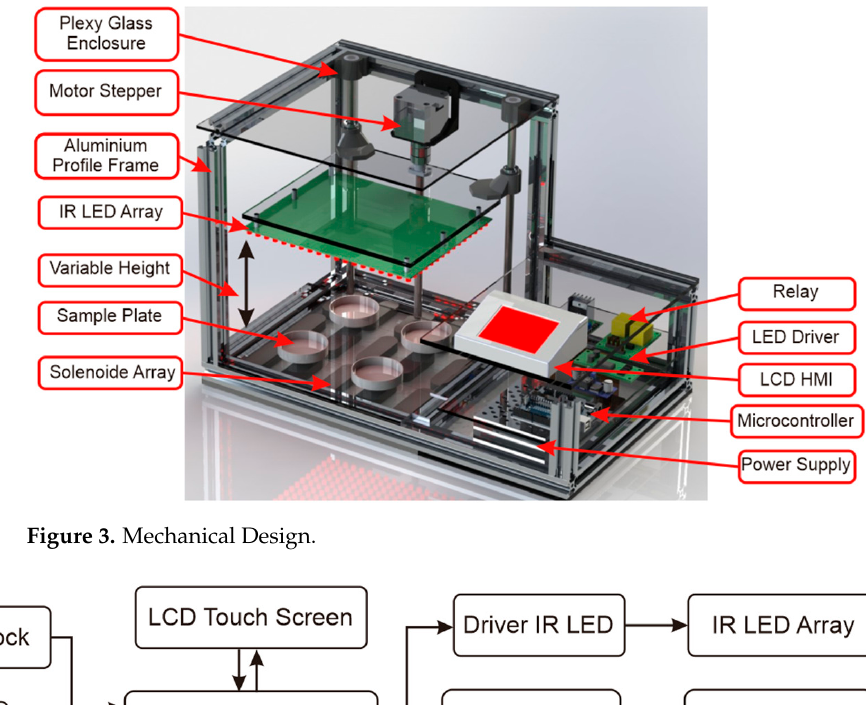
Figure 3. Mechanical Design.